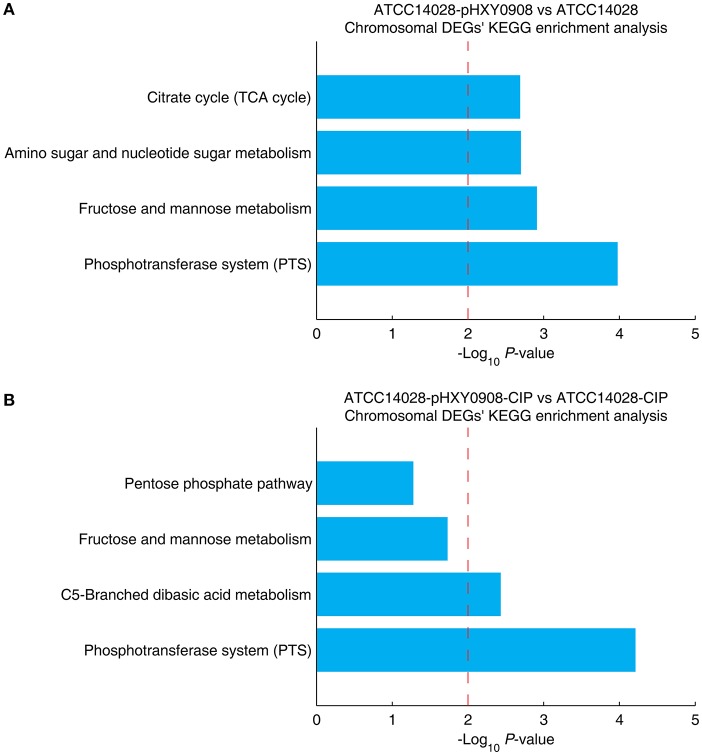
The chromosomal DEGs KEGG pathway enrichment analysis. (A) ATCC14028-pHXY0908 vs. ATCC14028 and (B) ATCC14028-pHXY0908-CIP vs. ATCC14028-CIP (B). The dotted red line indicates the P-value threshold of 0.01.